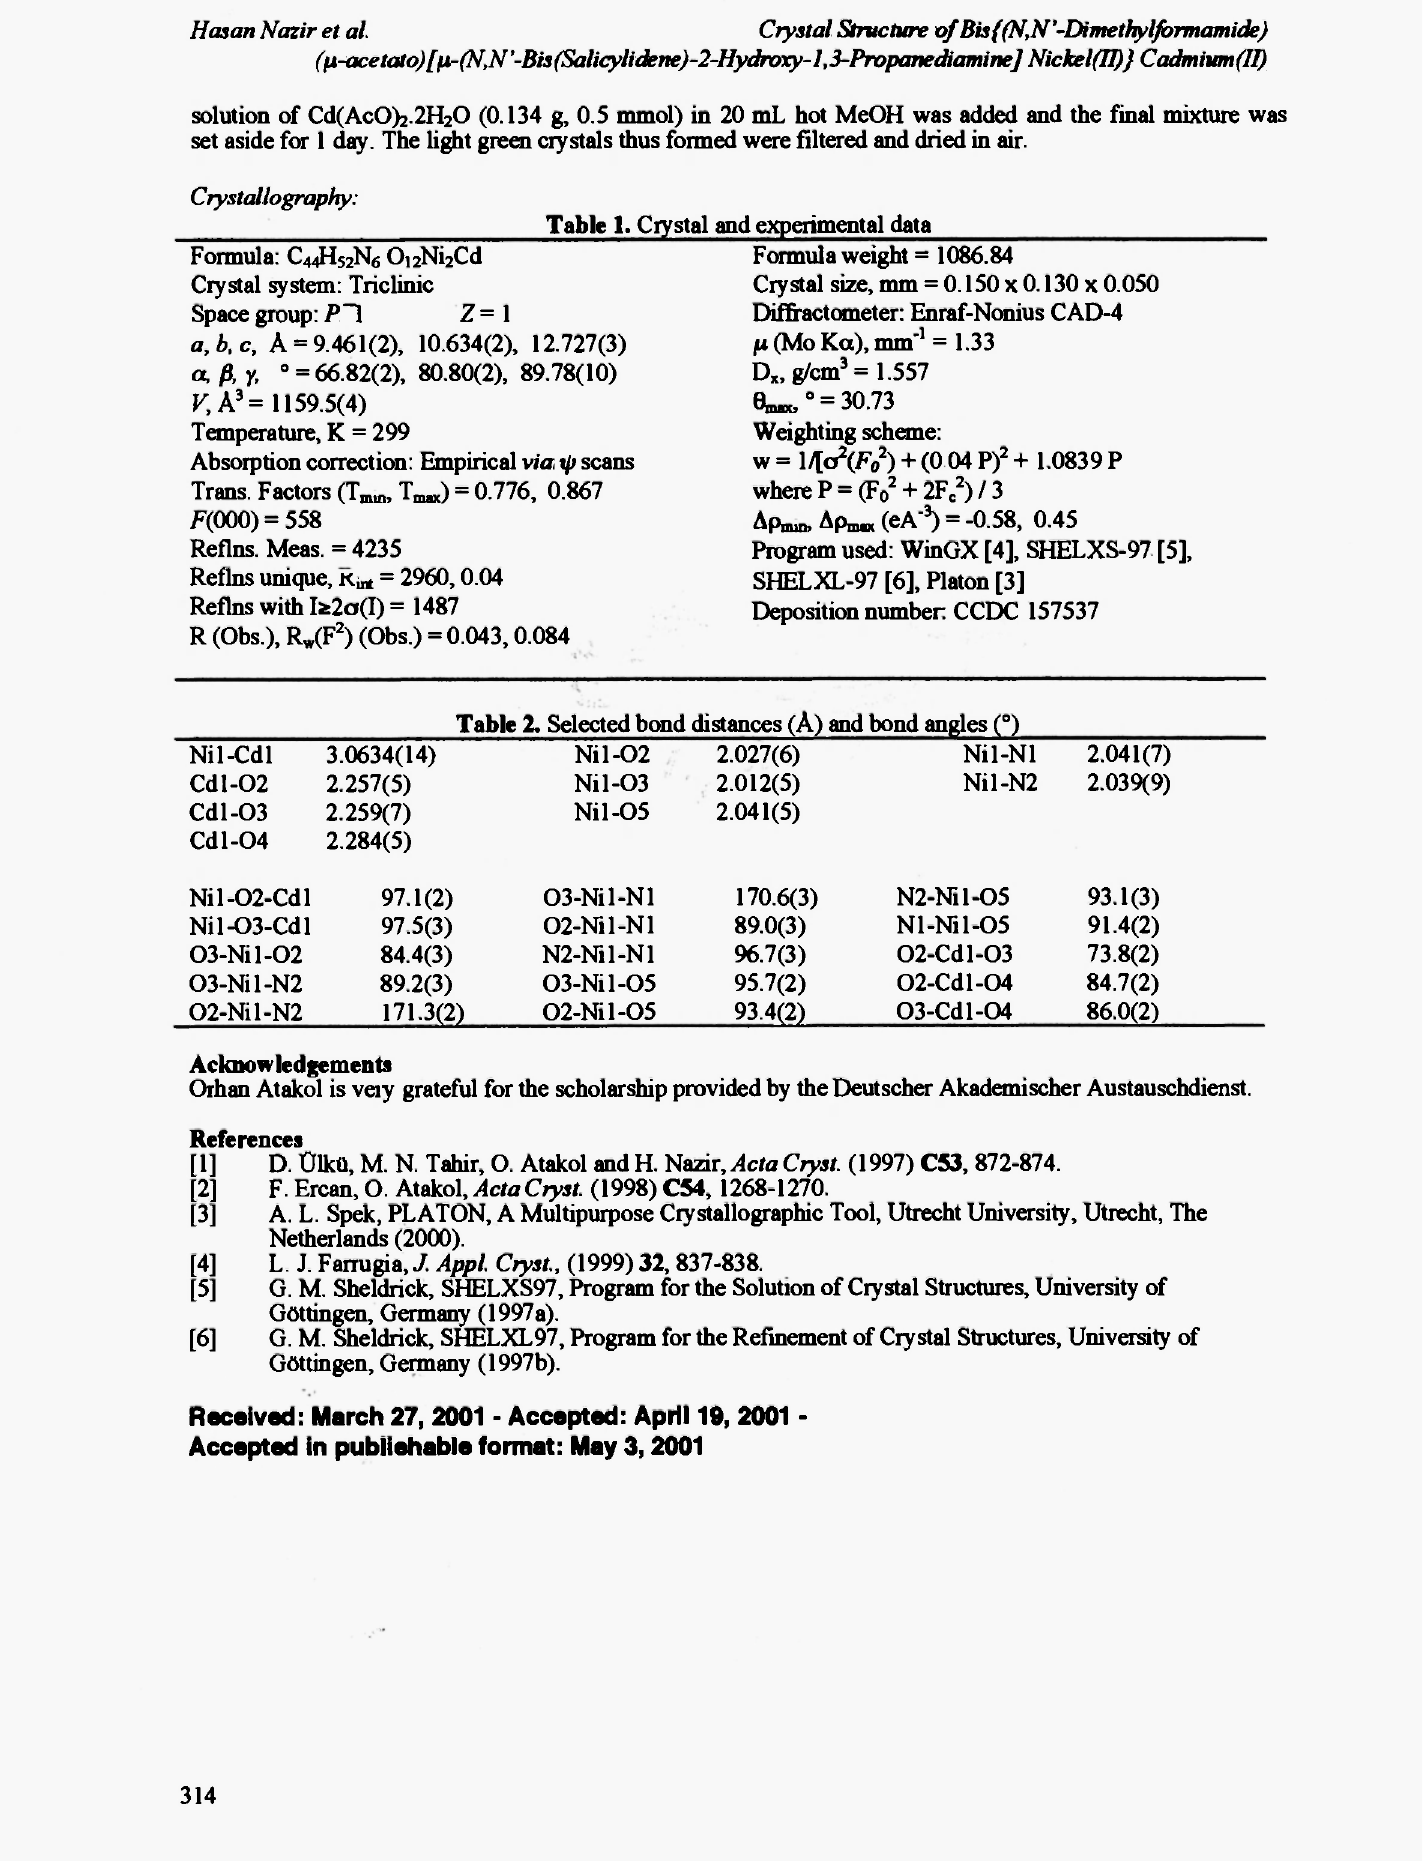
Table 2. Selected bond distances (A) and bond angles